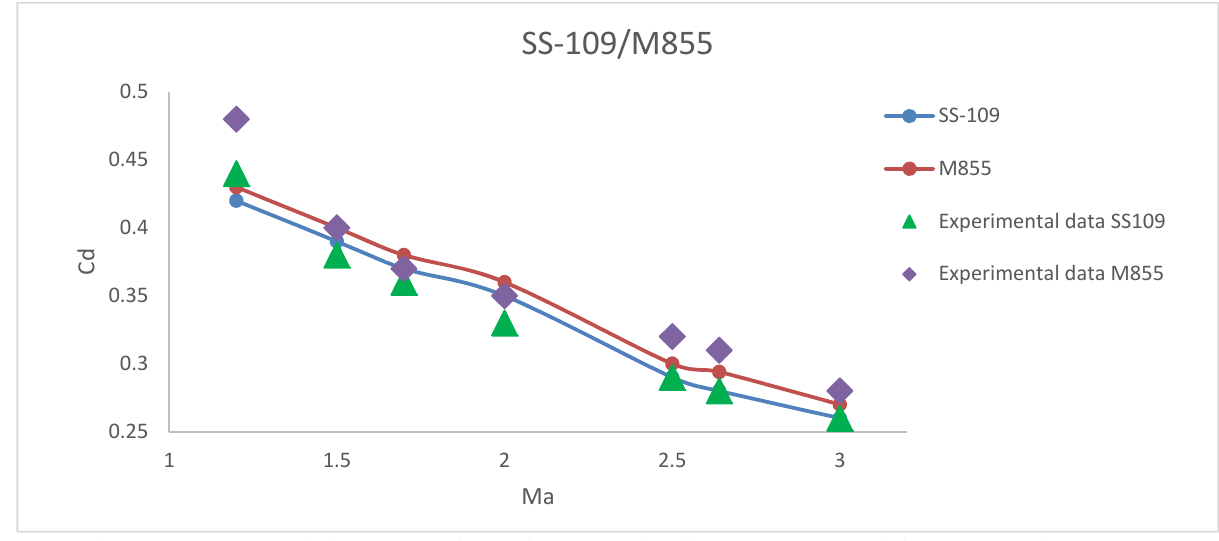
Figure 4. Drag coefficient vs Mach number for projectiles 5.56 mm, models SS109 and M855 [5]